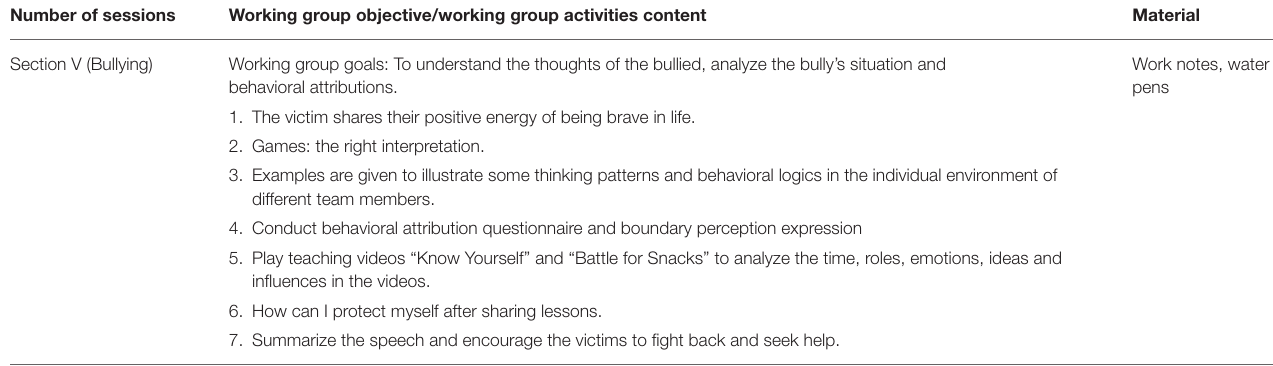
TABLE 7 | Behavior lying of bullied behavior. Number of